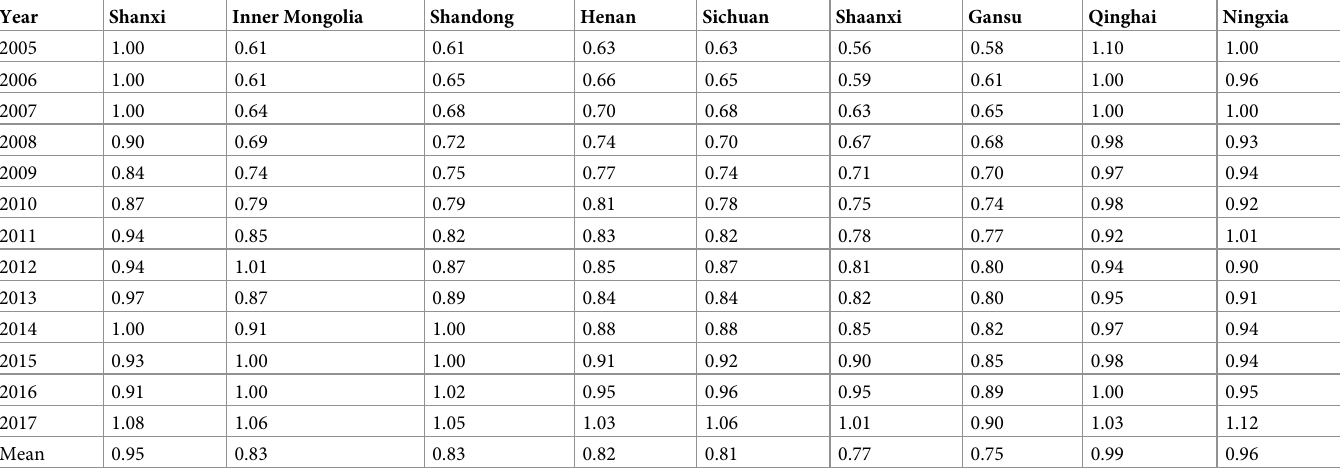
Table 4. The carbon emission efficiency of the YRB in